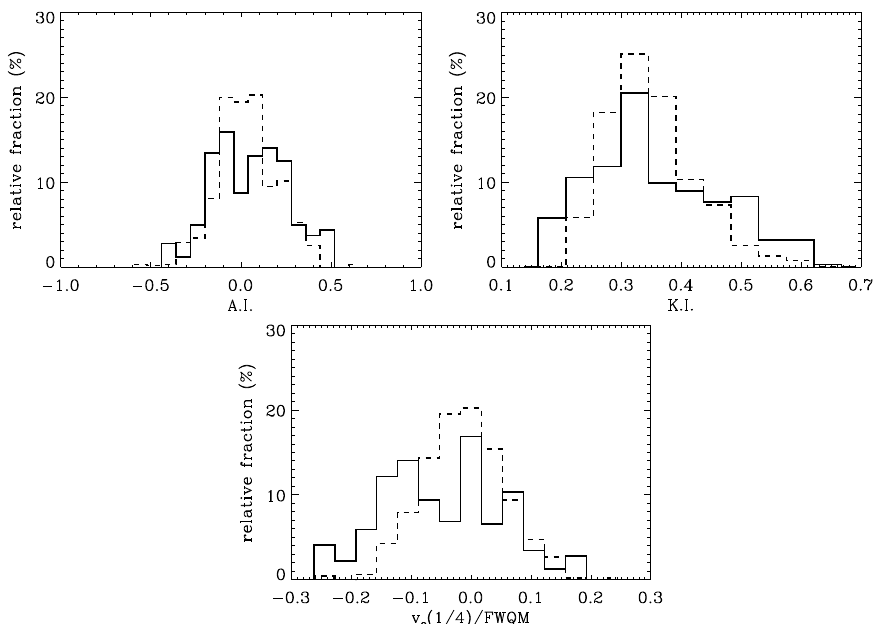
Fig. 2. Distributions of the simulated line profile parameters, after restricting the parameter range to i (cid:20) 45 ◦ , r in (cid:20) 2000 r g , r out (cid:21) 5000 r g and (cid:28) 0 (cid:21) 10 − 3 , are shown by the solid lines. The observed distributions from Zamfir et al. (2010) are plotted as the dashed lines.